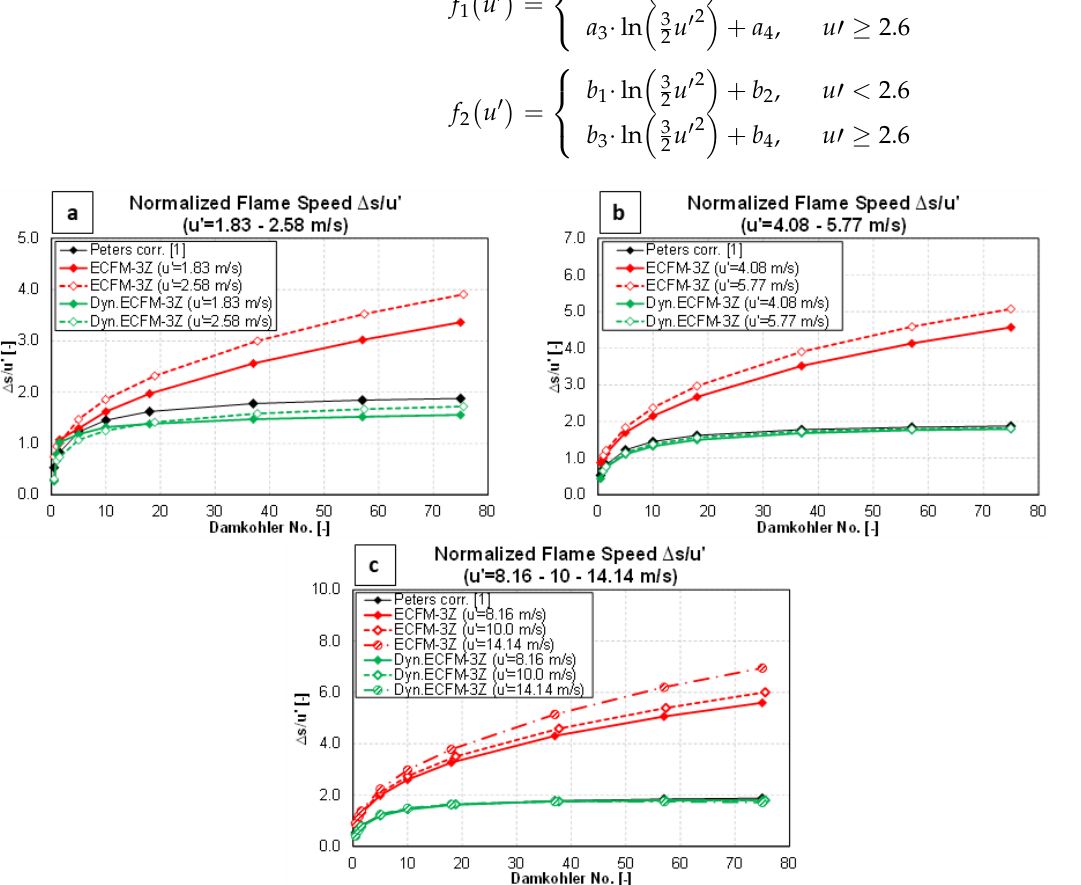
Figure 7. Normalized flame speed ∆𝑠 𝑢′⁄ for ECFM-3Z (Model 1): reference exp. values from Peters [1] ( ∆𝑠 𝑢′ ∗ ⁄ , black), original ECFM-3Z results ( ∆𝑠 𝑢′ 𝐶𝐹𝐷 ⁄ , red), and dynamic ECFM-3Z results ( ∆𝑠 𝑢′ 𝐶𝐹𝐷∗ ⁄ , green). Results for u ′ = 1.83 – 2.58 m/s ( a ), u′ = 4.08 – 5.77 ( b ), and u′ = 8.16 – 10 – 14.14 m/s ( c ).